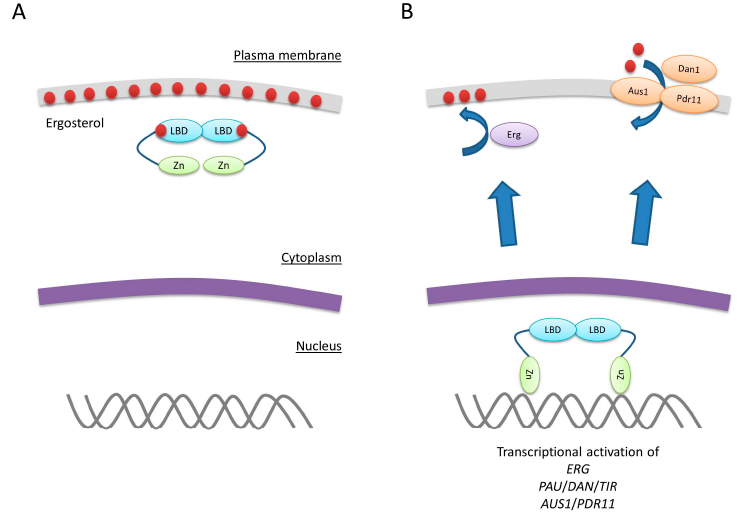
Figure 4. Regulation of Upc2 activity through lipid sensing. ( A ) When ergosterol (red spheres) levels are high it binds to the lipid-binding domain (LBD) of Upc2 and keeps the protein in the cytoplasm, possibly because the lipid-binding domain masks the NLS that lies adjacent to the Zn(II) 2 Cys 6 motif (Figure 2) (Zn). ( B ) When sterol levels drop ergosterol no longer binds to Upc2. This might trigger a conformational change of the protein, which results in a translocation to the nucleus. In the nucleus Upc2 induces genes involved in sterol biosynthesis, sterol uptake and general adaptations to anaerobic conditions.